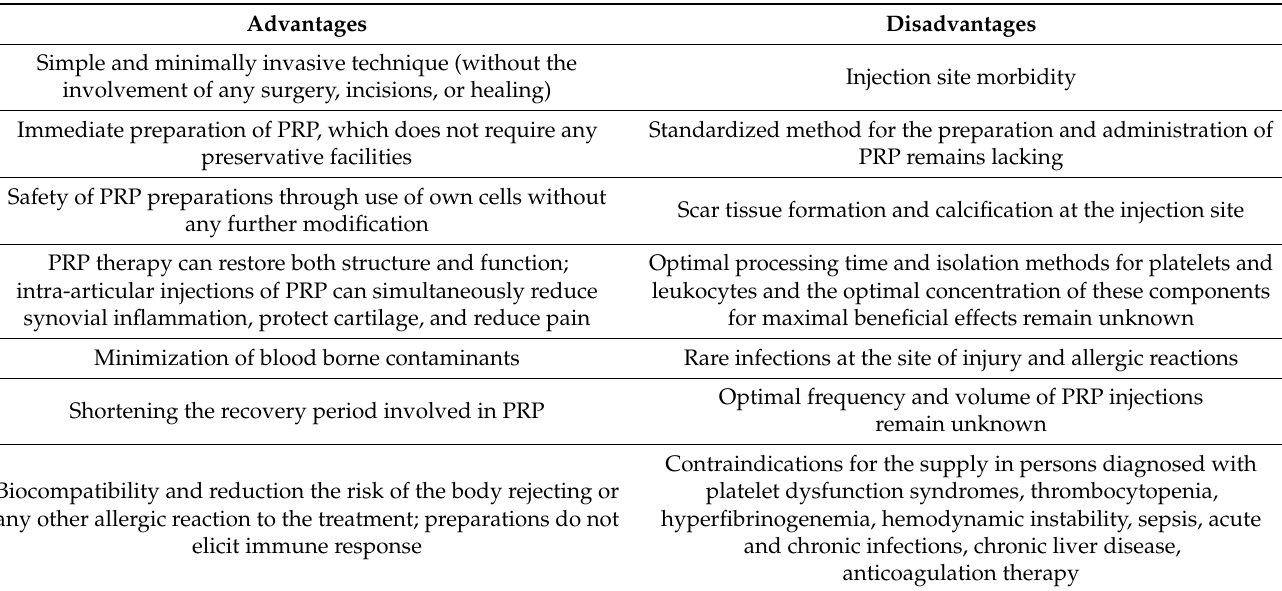
Table 2. Platelet-rich plasma therapy pros and cons